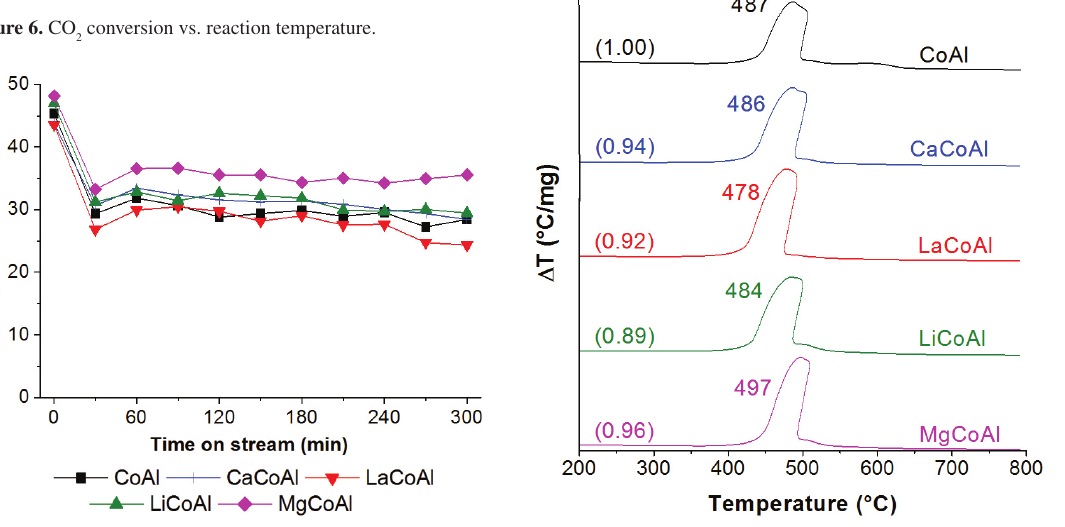
Figure 7. Evolution of CH conversion with time on stream. Figure 8. TPO/DTA curves for spent 4